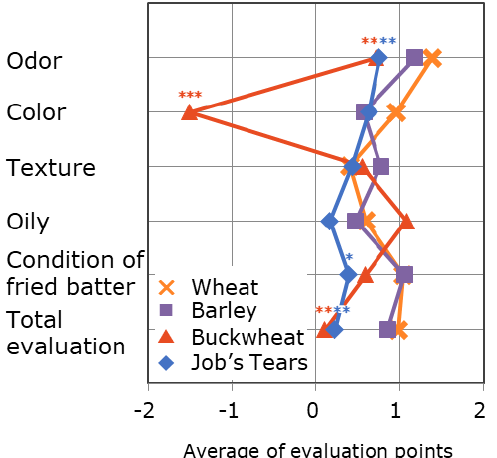
Figure 4. Preference sensory evaluation. Each value is expressed as the mean for each criterion. *** p < 0.001, ** p < 0.01, * p < 0.05 compared with the wheat sample (Dunnett test), n = 49. Panel: female